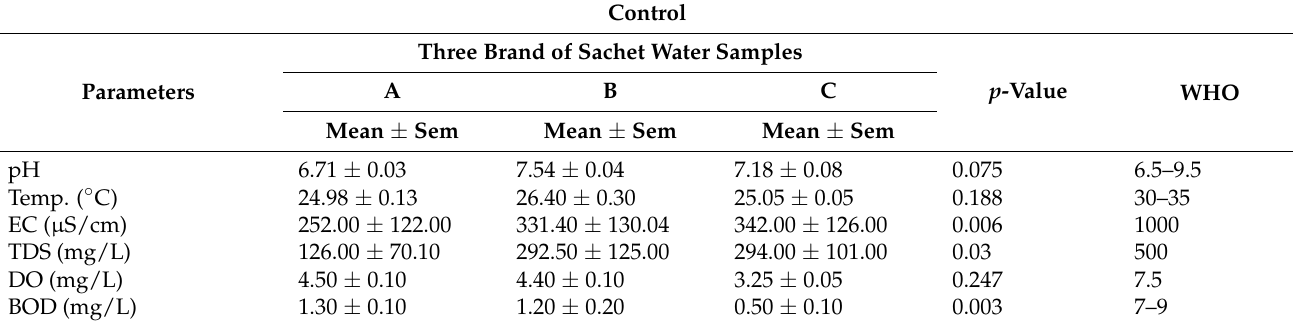
Table 3. Descriptive statistical analysis of physicochemical parameters and microbial quality of the three sachet water brands subjected to different storage